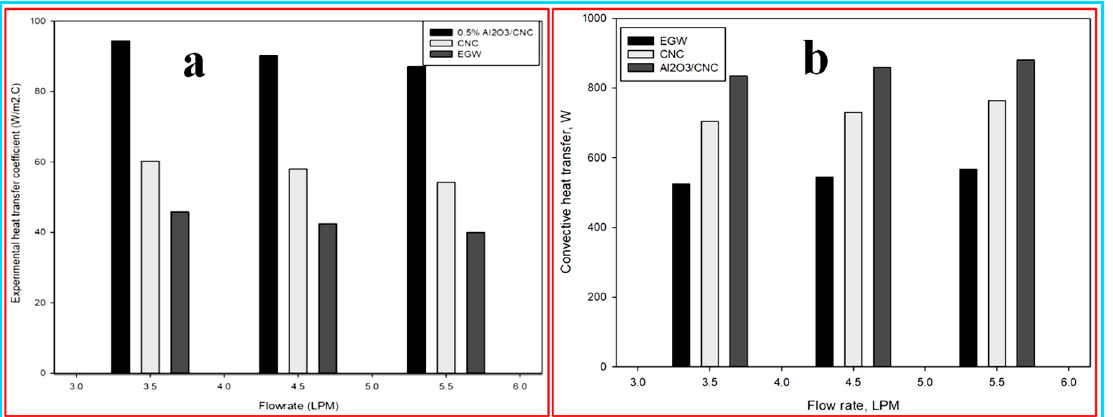
Figure 11. ( a ) Experimental heat transfer coefficient, and ( b ) Convective heat transfer as a function of the flow